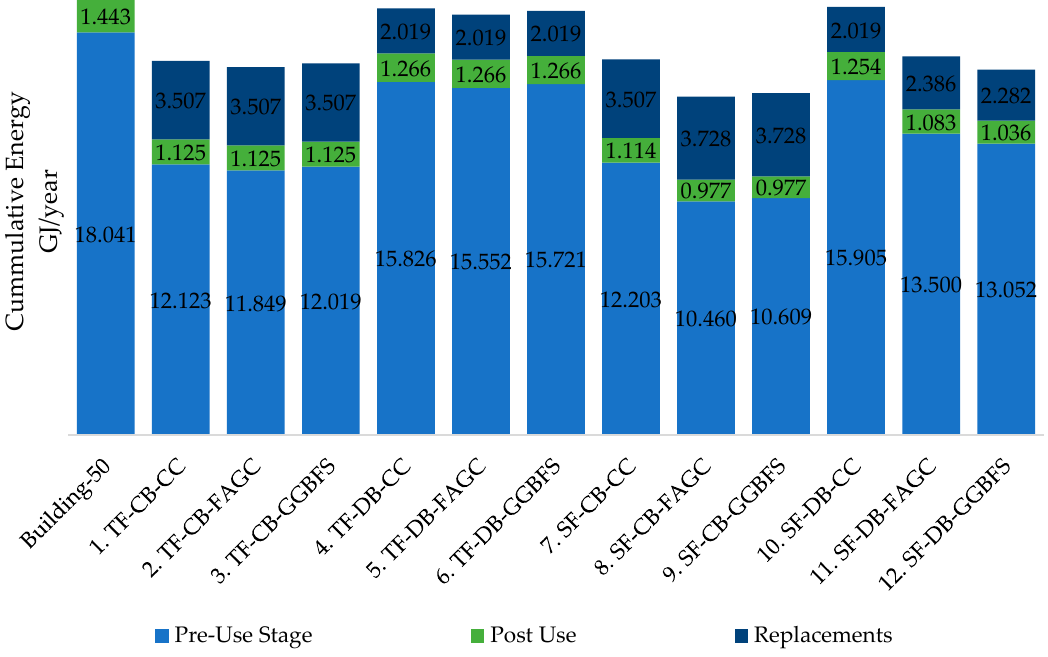
Figure 3. Cumulative Energy Demand per year per building, for 12 buildings and Building-50. (Use stage is omitted in the graph as the use-stage CED value 82.634 GJ/year is uniform in all cases and if plotted on same scale, other stages due to low values cannot be presented properly).